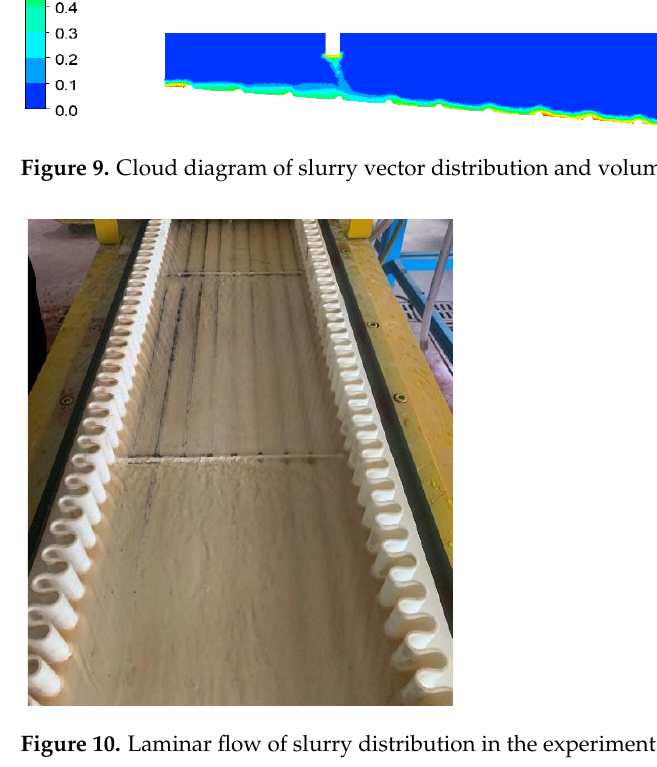
Figure 10. Laminar flow of slurry distribution in the experiment process.